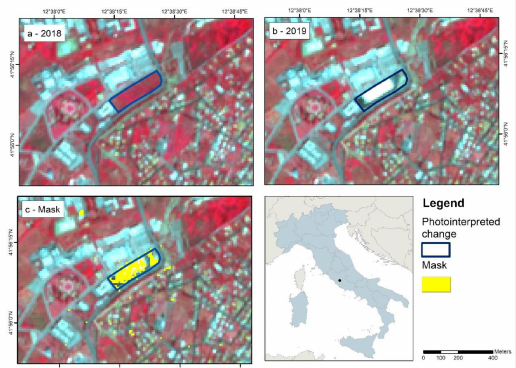
Figure 10. Example of change photointerpreted by ISPRA-SNPA and the change detected with the developed methodology. ( a ) Copernicus Sentinel-2 image (2018) before the land consumption highlighted with blue contour; ( b ) Copernicus Sentinel-2 image (2019) after the land consumption. ( c ) The area of potential changes identified with the third approach (yellow) is compared with the photointerpreted polygon